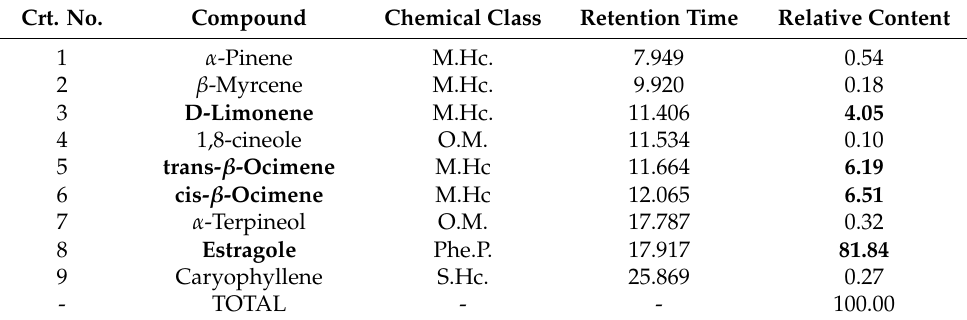
Table 1. Relative contents (%) of volatile constituents identified in tarragon essential oil. Crt. No. Compound Chemical Class Retention Time Relative Content 1 α -Pinene M.Hc. 7.949 0.54 β -Myrcene M.Hc. 9.920 0.18 D-Limonene M.Hc. 11.406 1,8-cineole O.M. trans- β -Ocimene